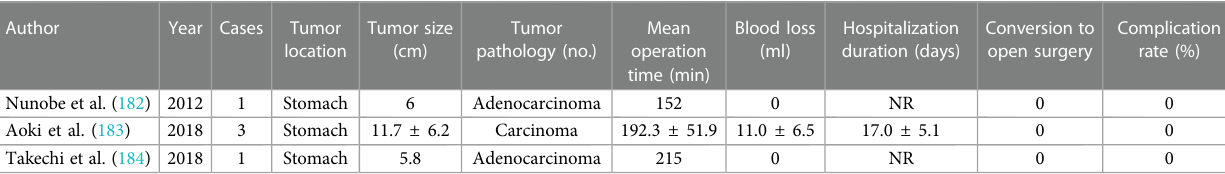
TABLE 13 Research studies of the inverted LECS